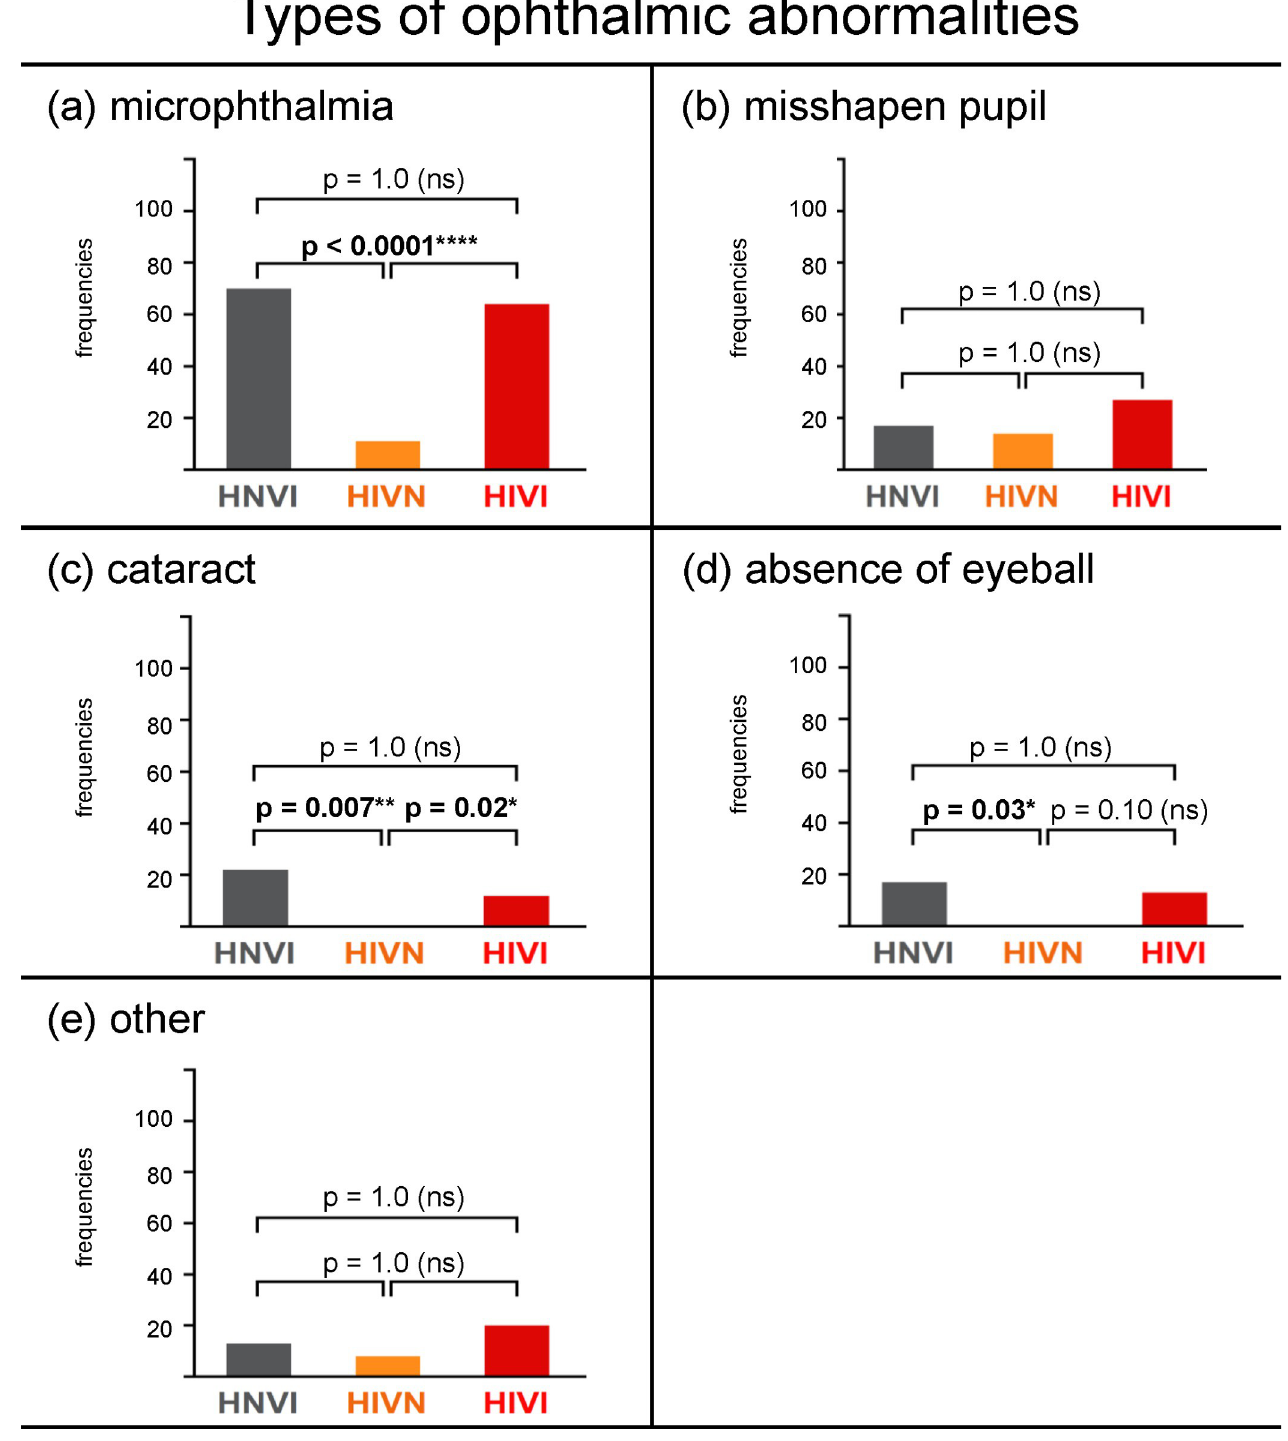
Fig 4. Frequencies of responses, in percentages, obtained for each sensory impaired group for the following ophthalmic abnormalities: (a) microphthalmia, (b) misshapen pupil, (c) cataract, (d) absence of eyeball, and (e) other. HNVI = hearing normal vision impaired (grey), HIVN = hearing impaired vision normal (orange), HIVI = hearing impaired vision impaired (red), ns = non significant. Horizontal brackets show the two-by-two comparisons that were statistically assessed using Chi 2 tests.